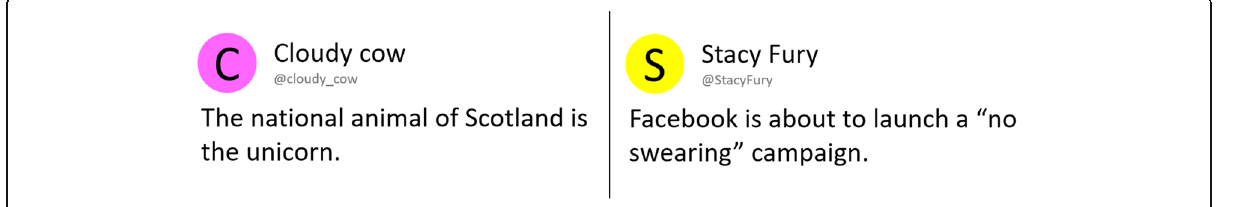
Fig. 1 Example of a true claim (left) and false claim